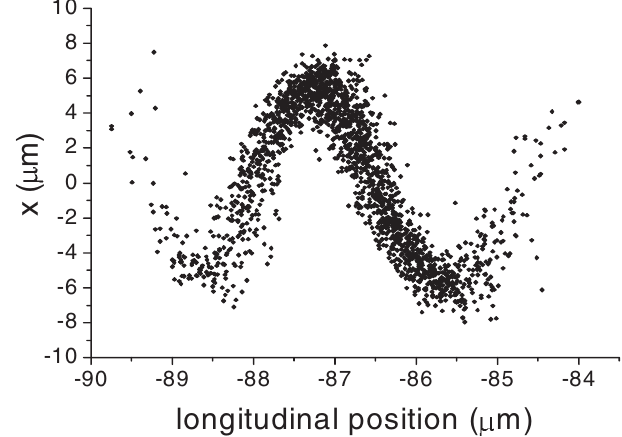
FIG. 10. Electron bunch after acceleration in a 5 cm plasma channel for off-axis injection. The bunch is injected at (cid:6) (cid:1) (cid:2) 9 : 6 (see Figs. 1 and 2), the other parameters of the calculation are the same as in Fig.